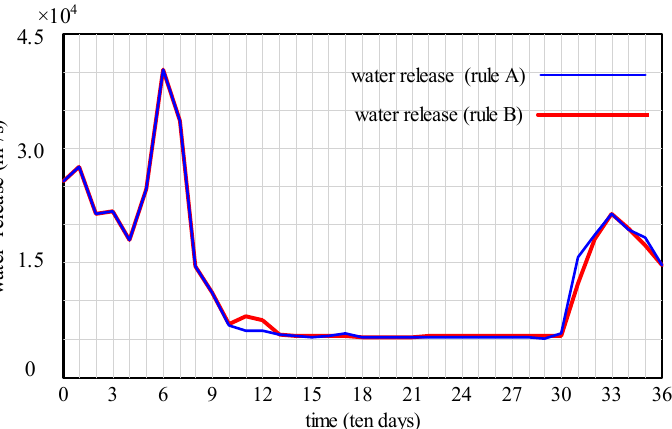
Figure 11. Water release process of TGR decided by operating rules A and B (the operating horizon is 11 June 2001 to 11 June 2002).